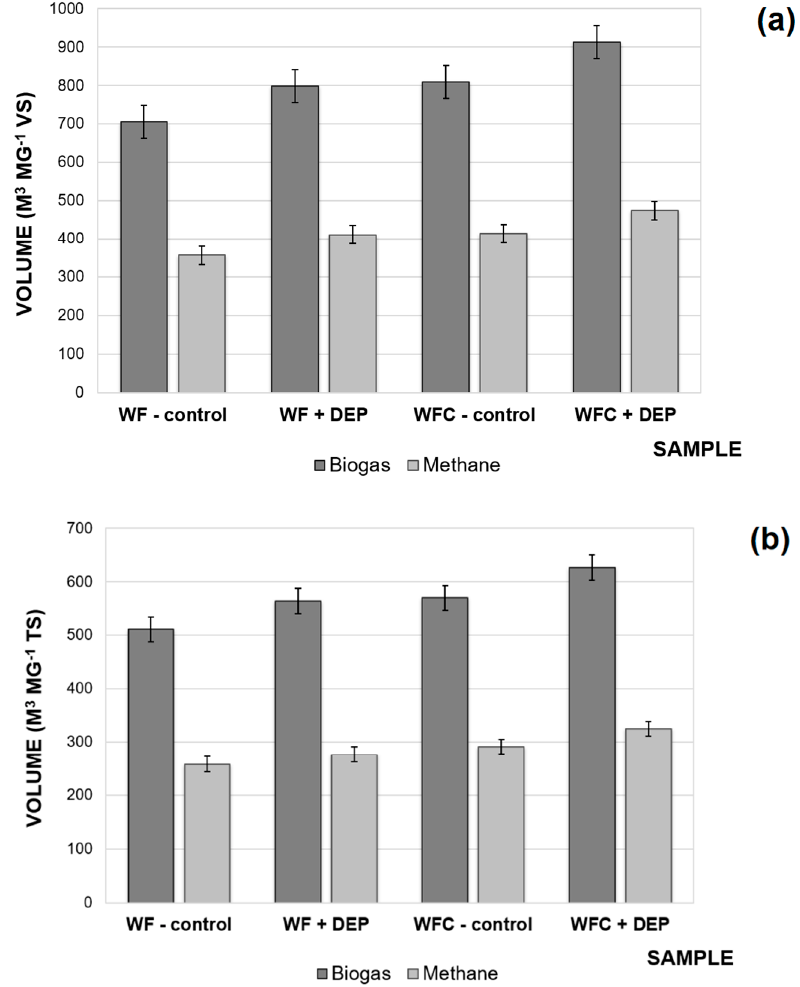
Figure 6. Biogas and methane efficiency from Mg of ( a ) volatile solids (VS) and ( b ) total solids (TS) obtained from WF-control, WF + DEP, WFC-control, and WFC + DEP samples.